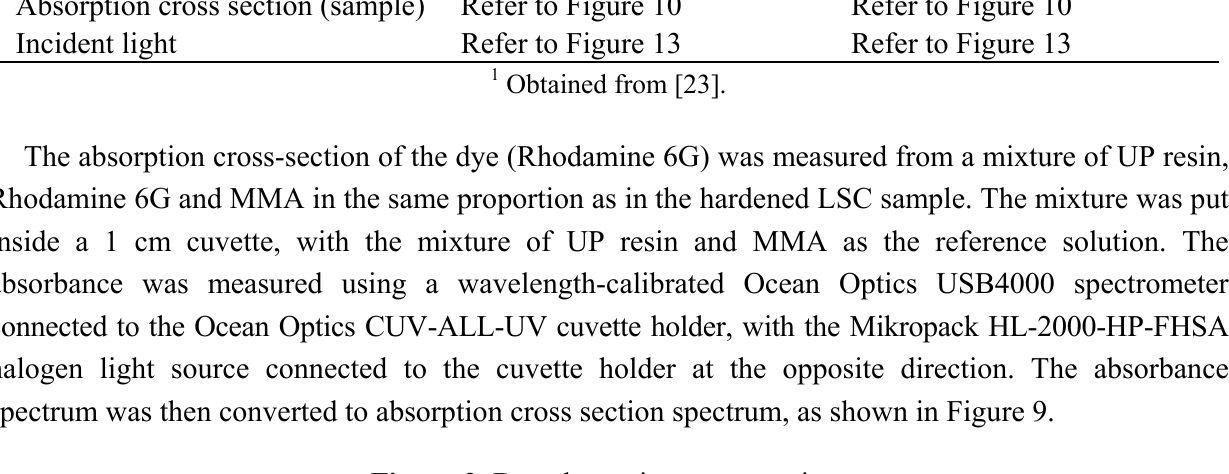
Figure 9. Dye absorption cross